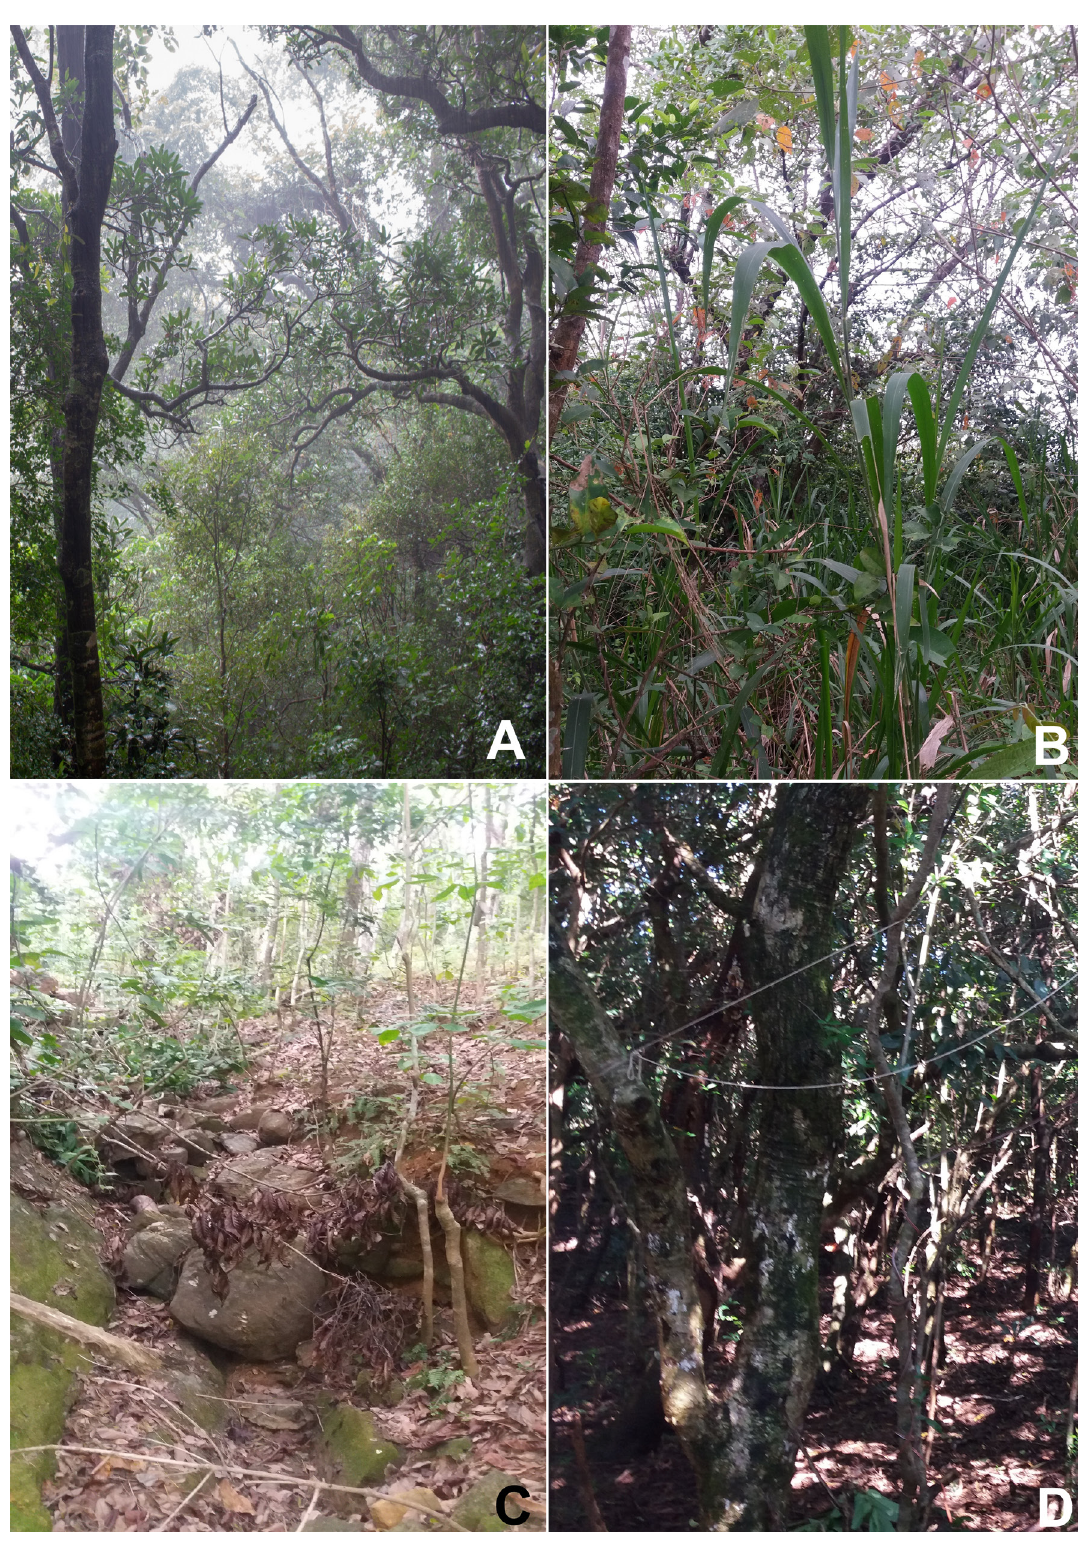
Fig. 6. Photos of the habitats of the new species. A . Selaserica athukoralai sp. nov. B .